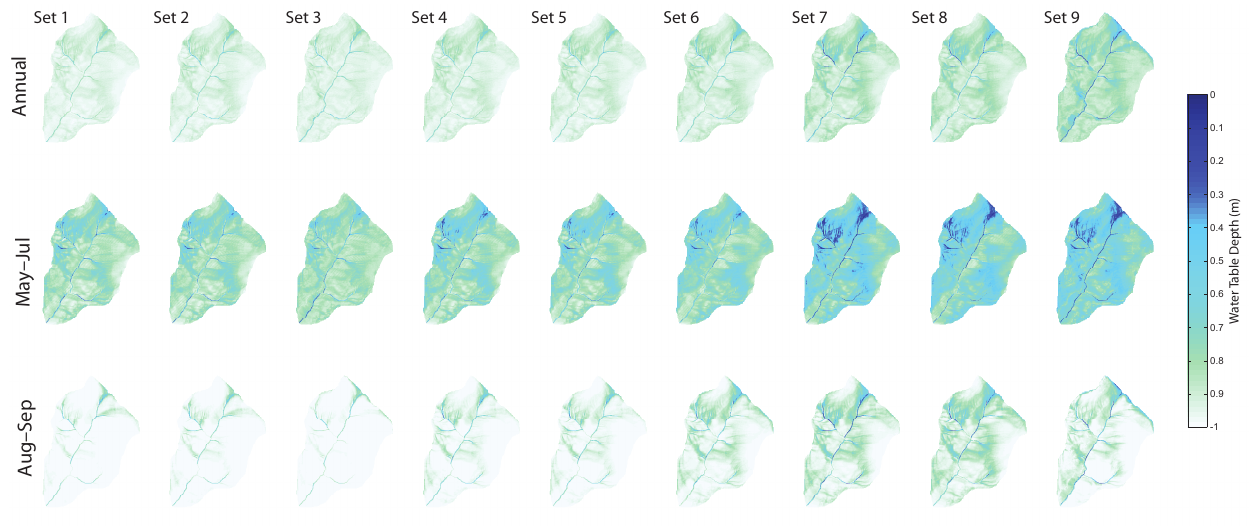
Figure B4. Predictions of annual, May–July, and August–September water table depths. Color indicates average depth across a given period between bedrock ( − 1m) and the surface (0m). Columns display predictions across nine parameter sets identified by the framework applied to Stringer Creek hydrology, with a subset of these (sets 1, 5, and 9) shown in Fig. 9.